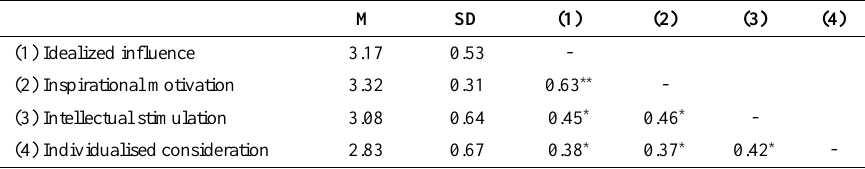
Table 5. Pearson correlation between dimensions of transformational leadership